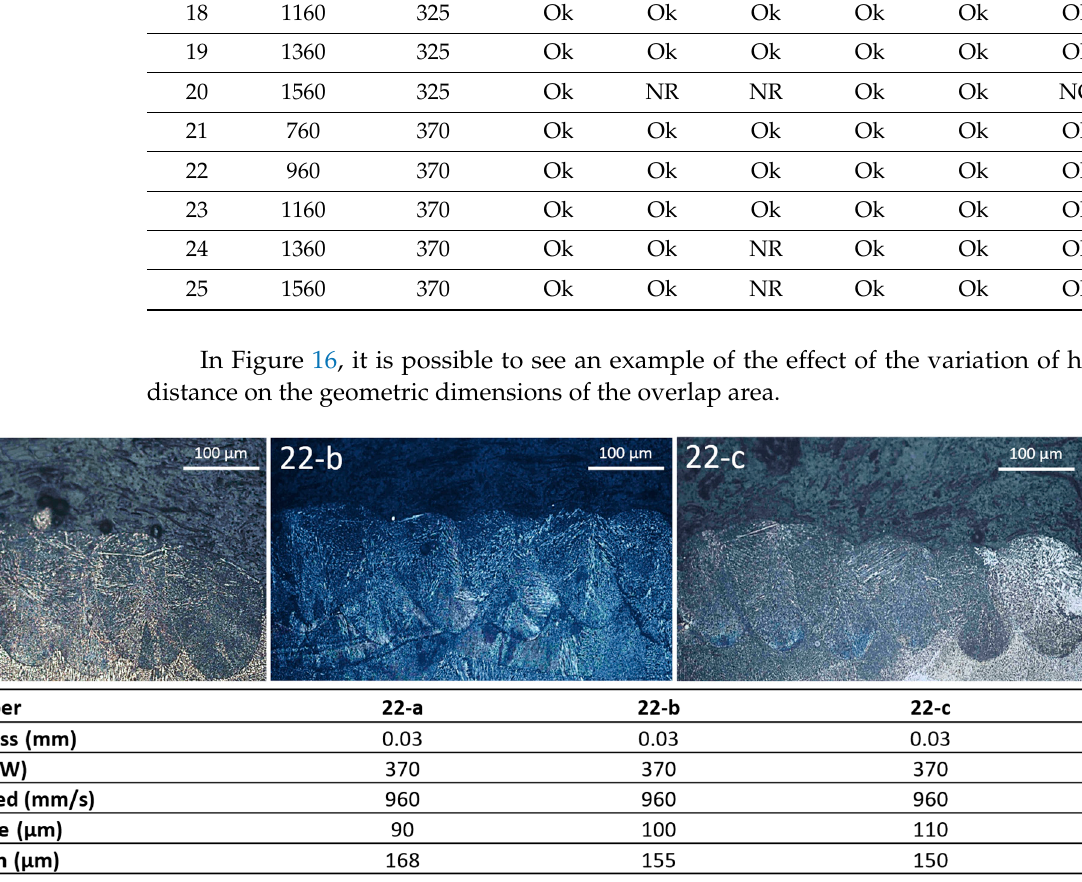
Table 9. Multi-tracks melt pool dimensions tracking table. The measure of each sample is referred to 0.09/0.10/0.11 mm as hatch distance I/II/III, respectively. The abbreviations NR and NO mean, respectively, “Not Remelting” and “Not Overlap”, SS and # mean scan speed and sample number.